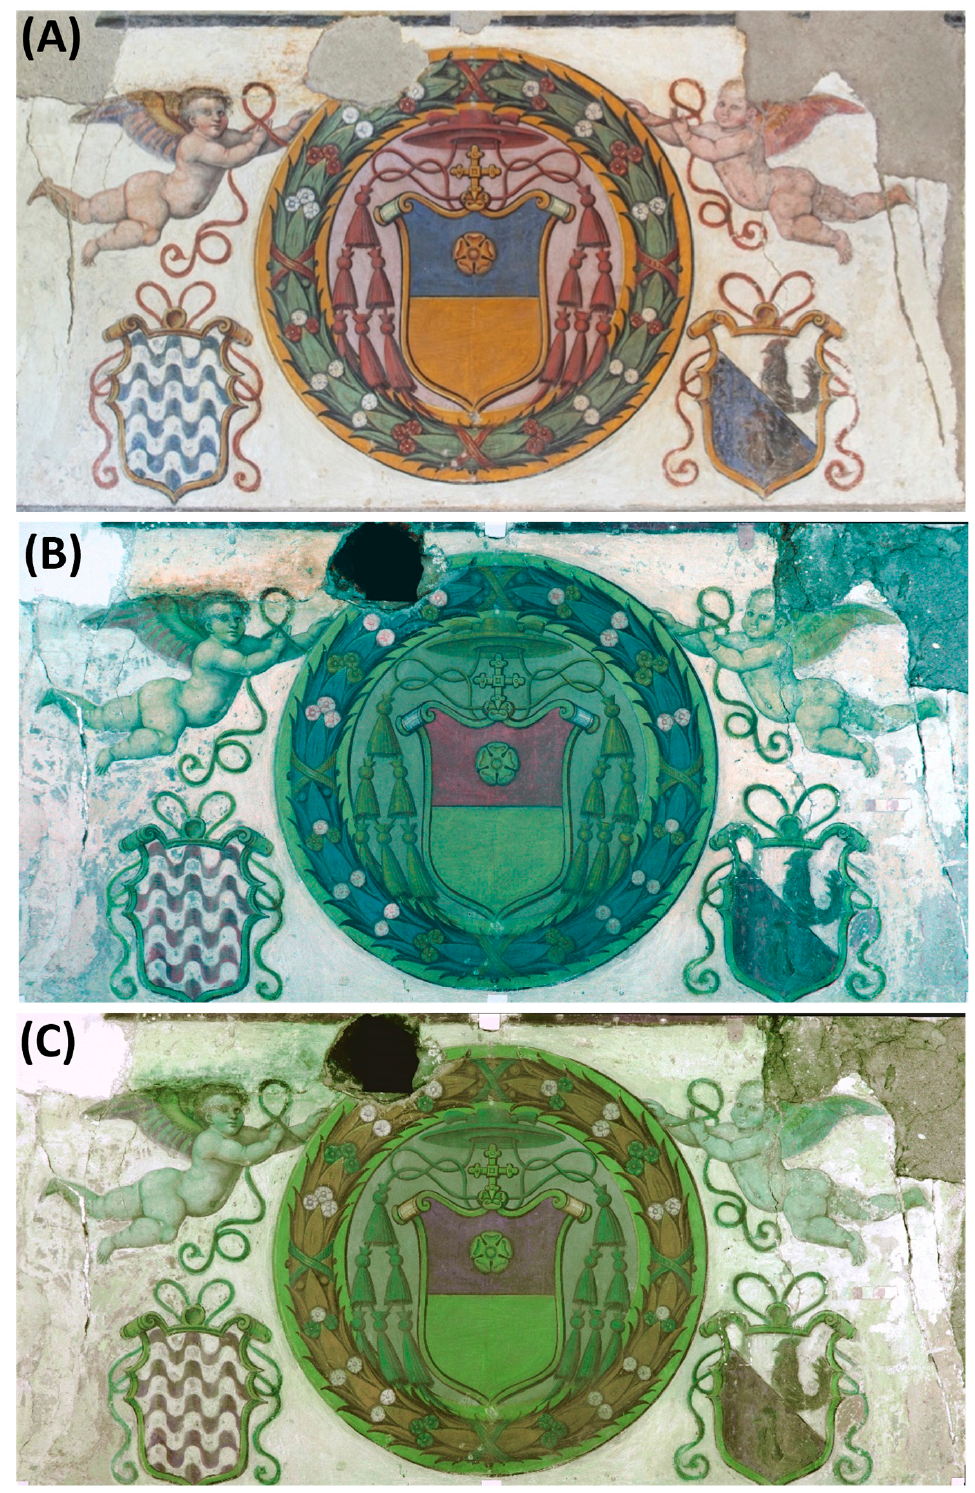
Figure 9. RGB ( A ), IRFC ( B ), and UVFC ( C ) images of the Riario coat of arms after the complete removal of the scialbo , obtained with PickViewer ® .